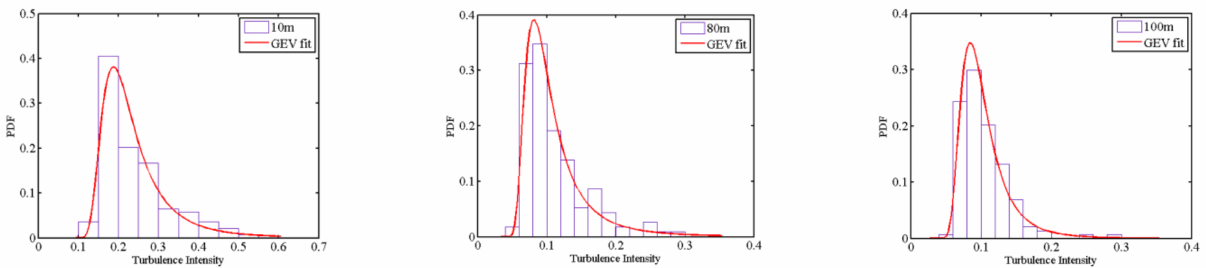
Figure 14. Turbulence intensity fitted by the GEV